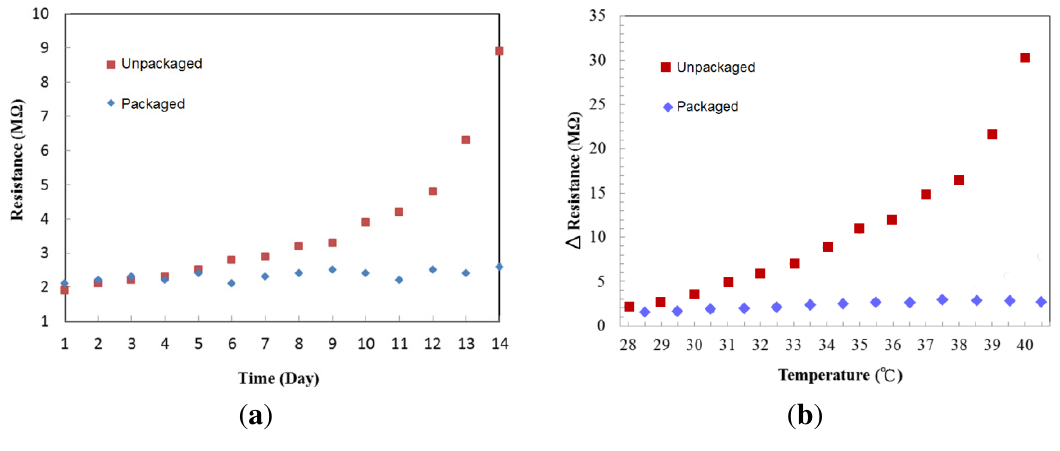
Figure 8. ( a ) Resistance changes in the low vacuum and ambient air environments room temperature, ( b )